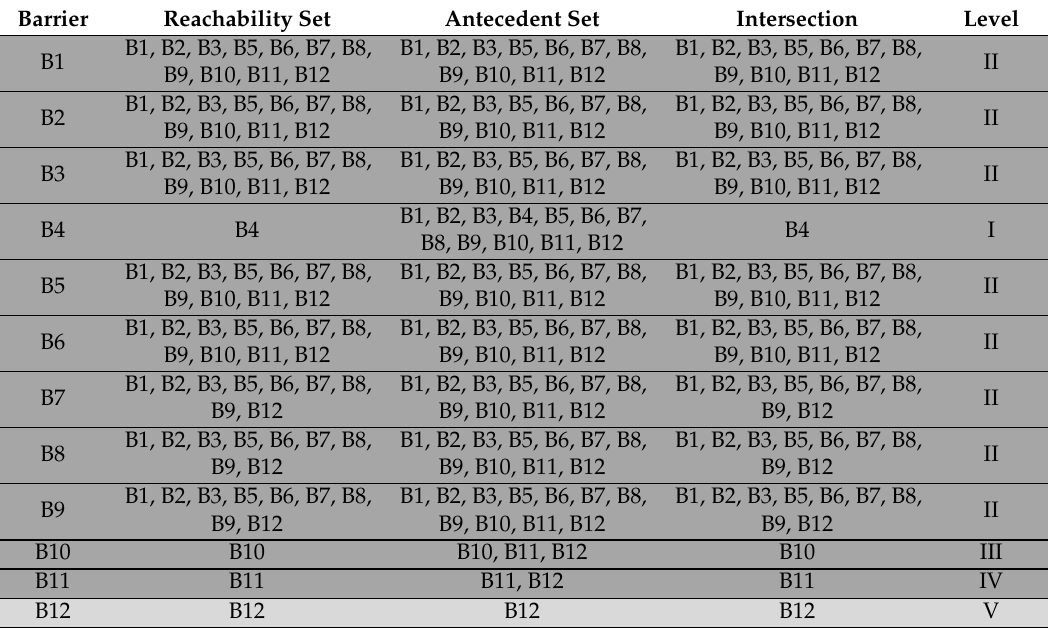
Table 9. Partition matrix (PM) and barrier (B1–B12) levels—5th iteration of ISM computations. Barrier Reachability Set Antecedent Set Intersection